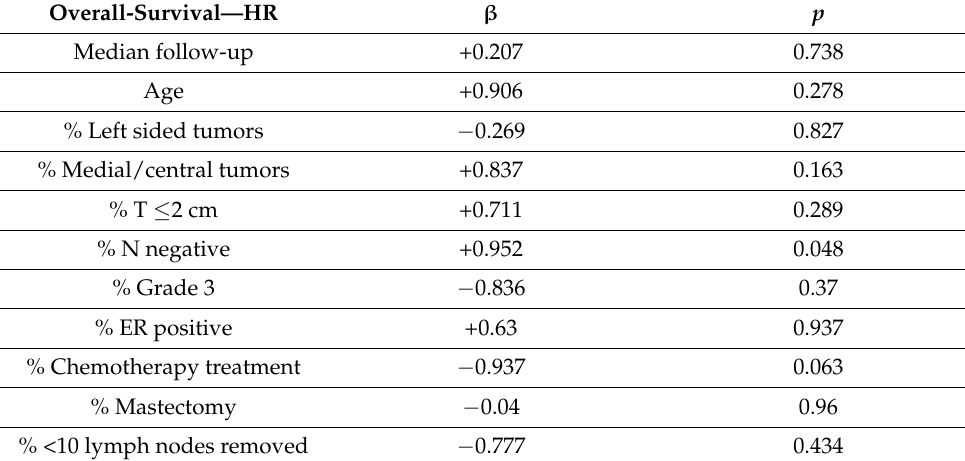
Table 4. The results of the meta-regression for overall-survival.